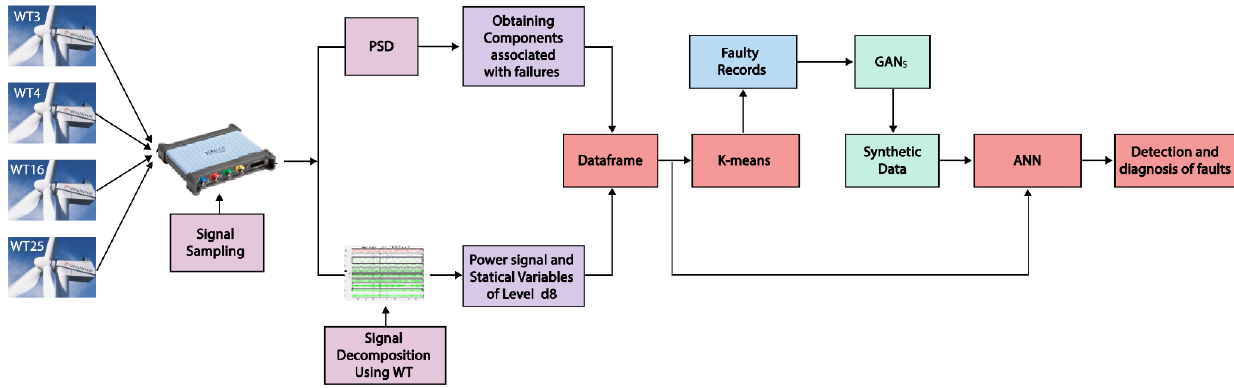
Figure 3. General scheme of the proposed model.